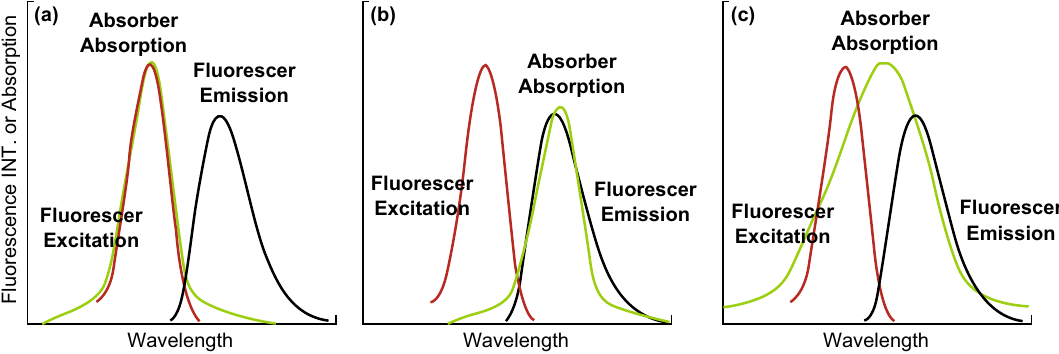
Fig. 14 Requisites for IFE: a the absorber spectrum overlaps the fluorescer excitation spectrum, b the absorber spectrum overlaps the fluorescer emission spectrum, and c the absorber spectrum overlaps the fluorescer excitation and emission spectra [110]. Copyright (cid:2) 2017 Elsevier